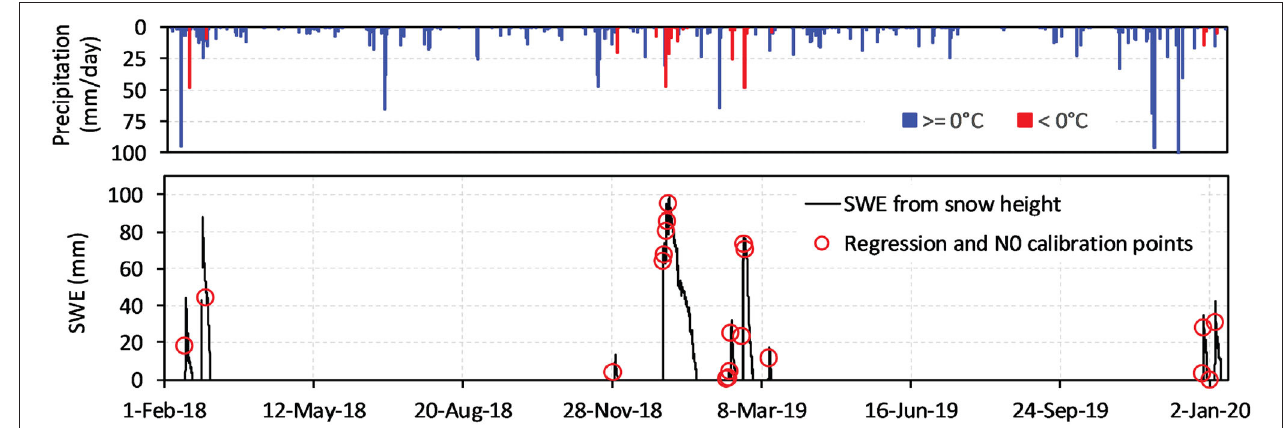
FIGURE 6 | Time series of precipitation and snow water equivalent derived from Equation (10), and the 20 snow depth observations selected for determining the relationship between SWE and CRNP measurements.